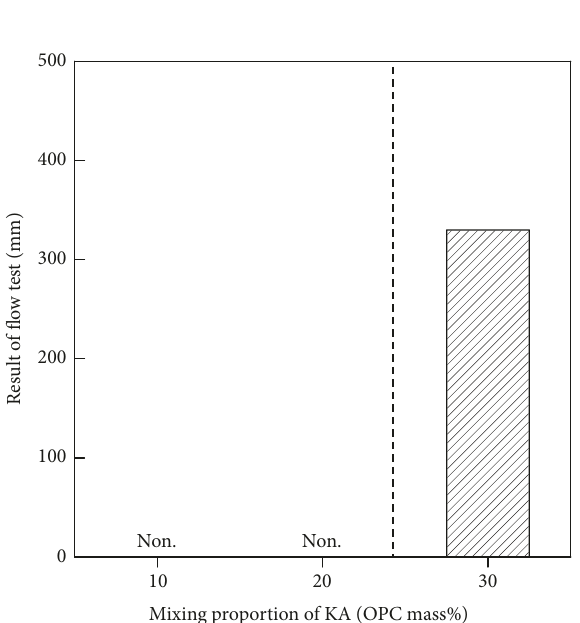
Figure 4: Results of flow test for Step 1